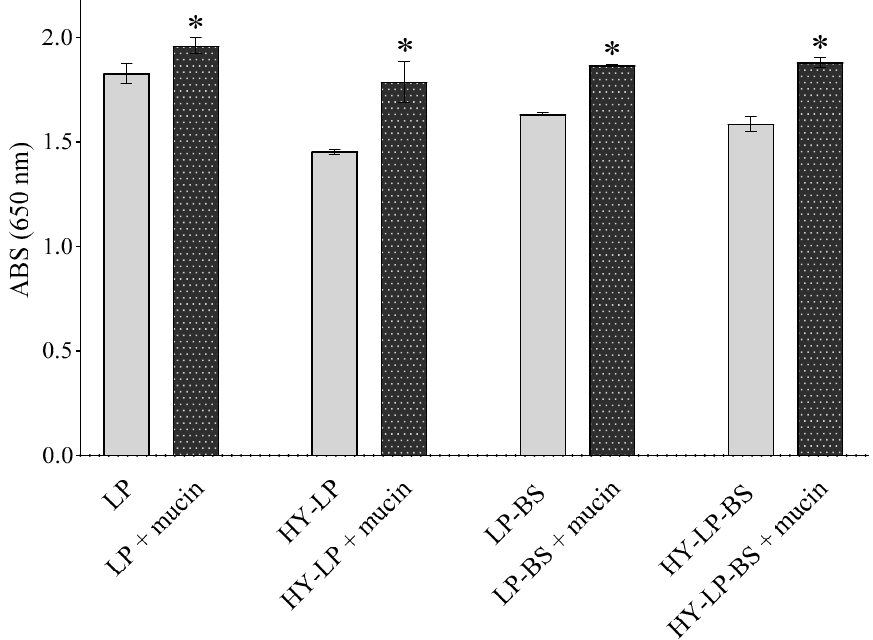
Figure 2. Absorbance at 650 nm measured for formulations incubated or not in the presence of mucin (mean ± SD, n = 3). The statistical significance with respect to formulation in absence of mucin was reported, *: p < 0.05.